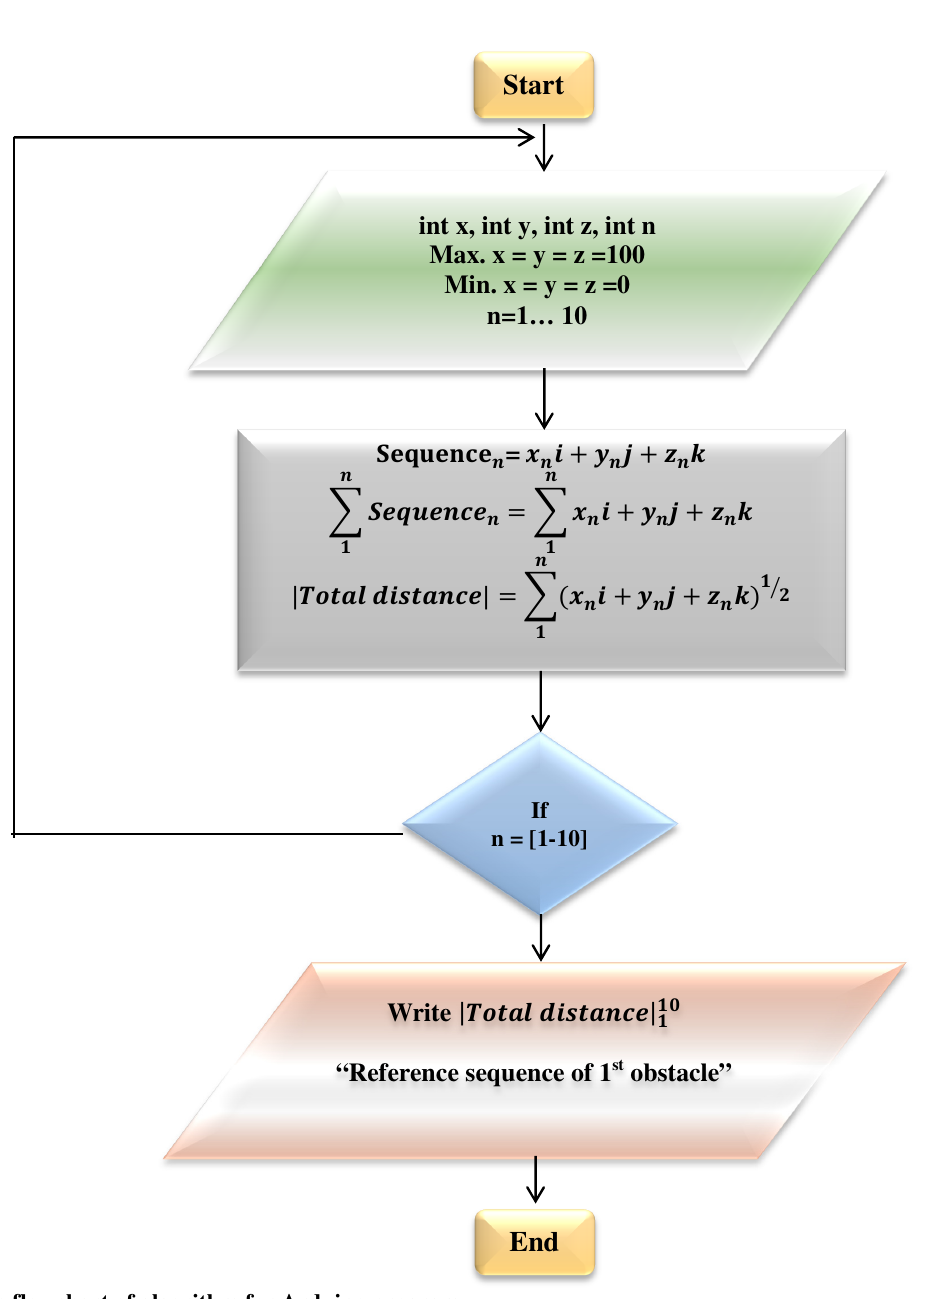
Fig.11. The flowchart of algorithm for Arduino